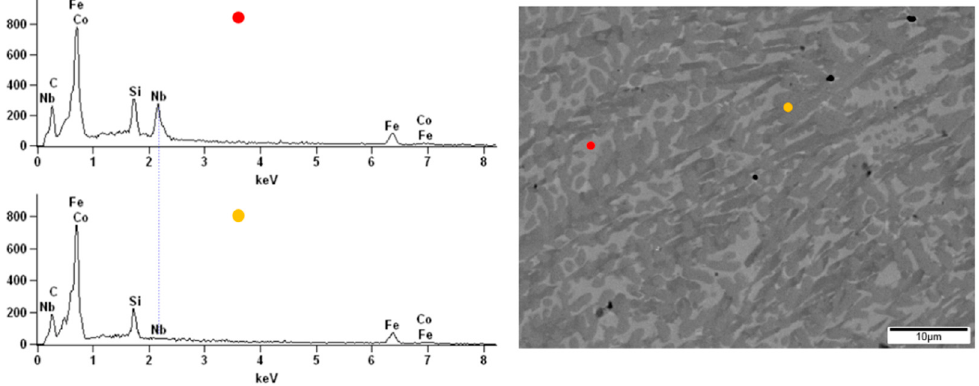
Figure 11. The SEM micrographs of surface and spectrums of the point EDX analysis for Fe 67 Co 10 B 12 Si 9 Nb 2 alloy.